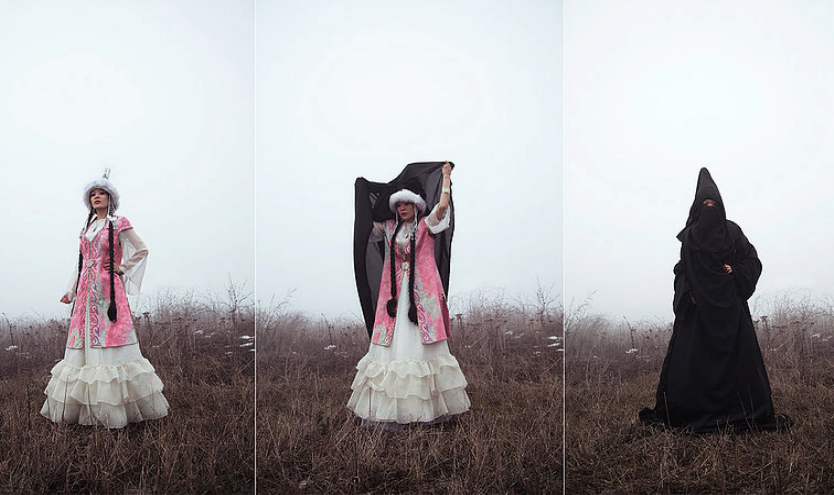
Figure 4. Anvar Musrepov, Kazakh Woman in a Burka (2016). Images courtesy of Anvar Musrepov. The young Kazakh woman’s dress, a national symbol, was thus substituted for a black outer garment associated with religious extremists, covering her body and face.